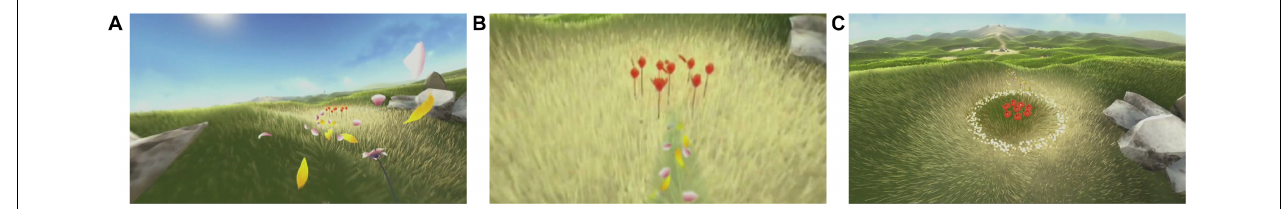
FIGURE 3 | Gameplay in Flower. Players steer flower petals toward (A) and past flowers (B) which then bloom and transform the environment (C) . These images are reproduced from Flower by Thatgamecompany (2009b) with the permission of the copyright holder Sony Interactive Entertainment.